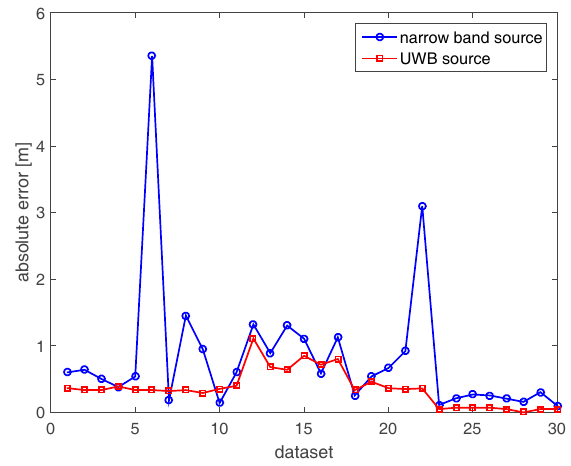
Figure 8. Positioning errors achieved with horizontal array (A).